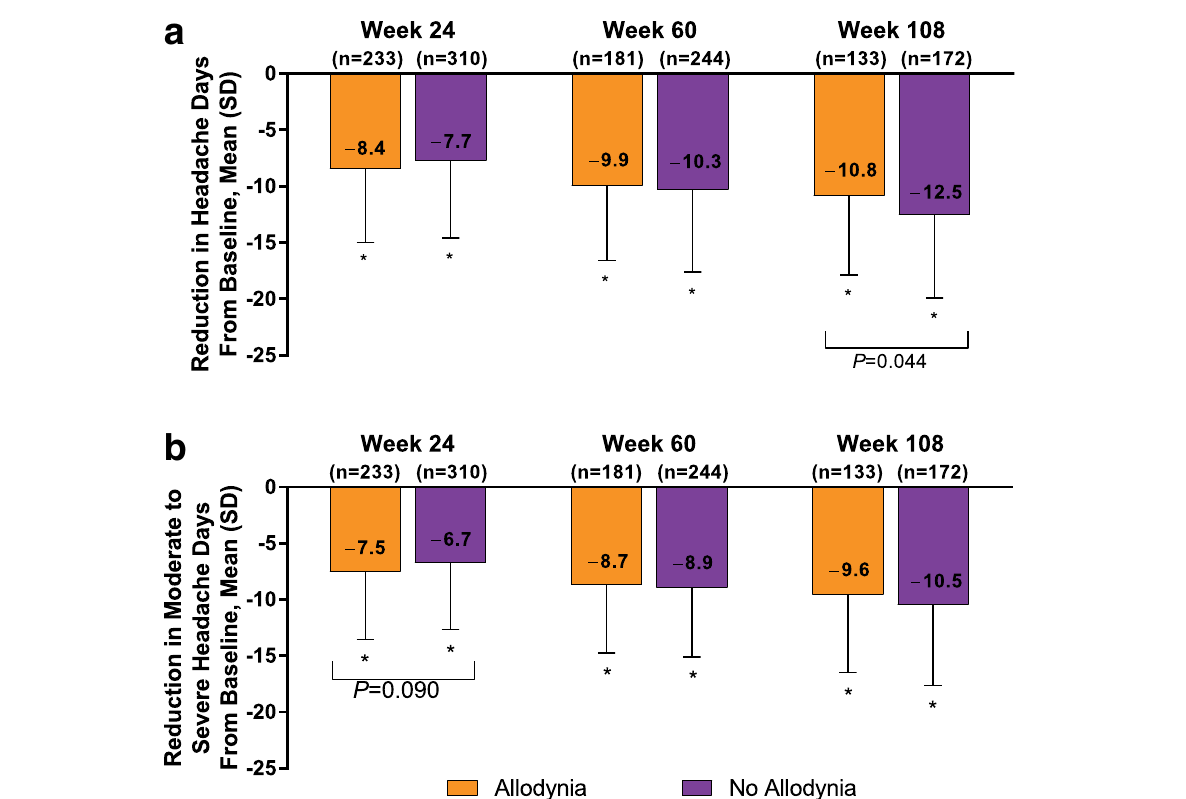
Fig. 1 OnabotulinumtoxinA effect on (a) headache days and (b) moderate to severe headache days. *Indicates P < 0.001 for within-group change from baseline. P values shown in the figure indicate between-subgroup differences in change from baseline; data are observed